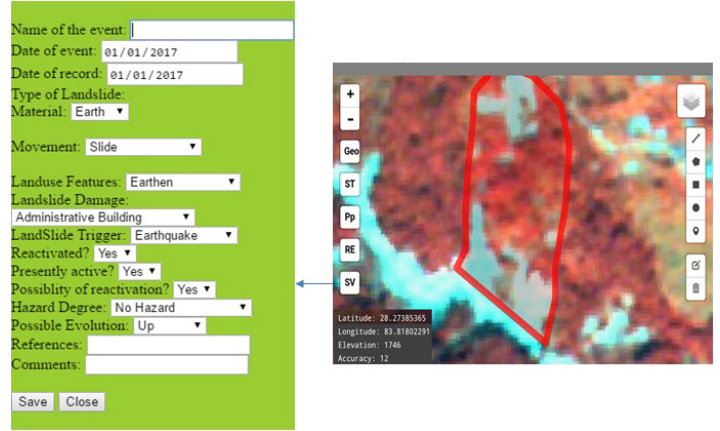
Figure 6. Offline component with a satellite image as the background: geolocation (Geo), stop geolocation (ST), show all the attributes in a pop up window (Pp), reset the map (RE), and save as GeoJSON text (SV) by filling the green from.